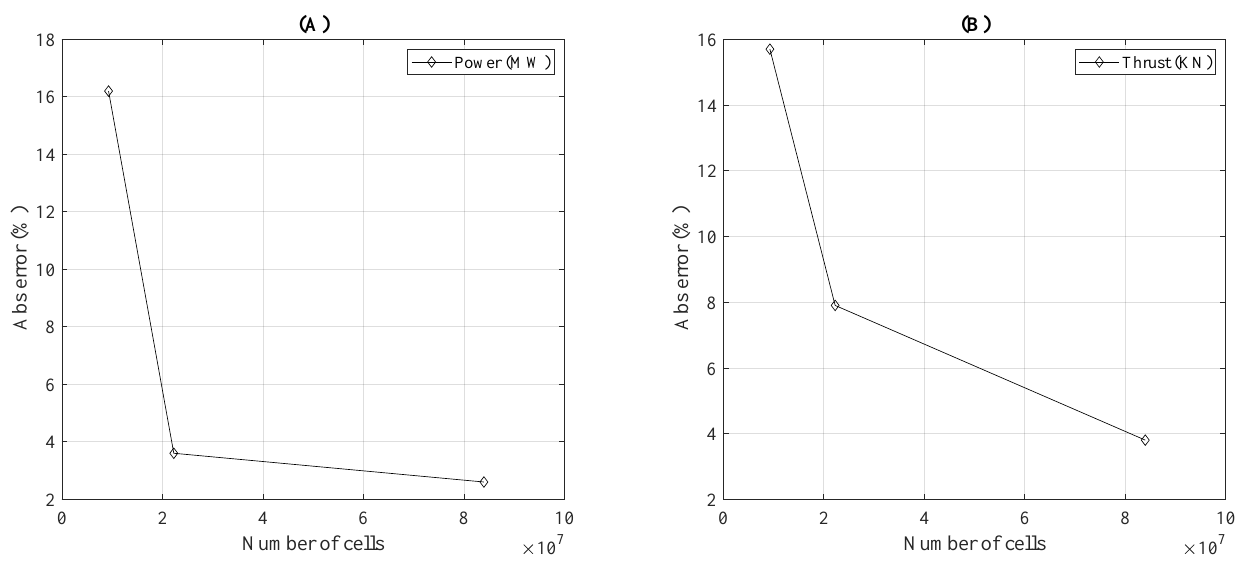
Figure 11. Percentage error of power ( A ) and thrust ( B ) of each mesh resolution from the NREL 5 MW data.